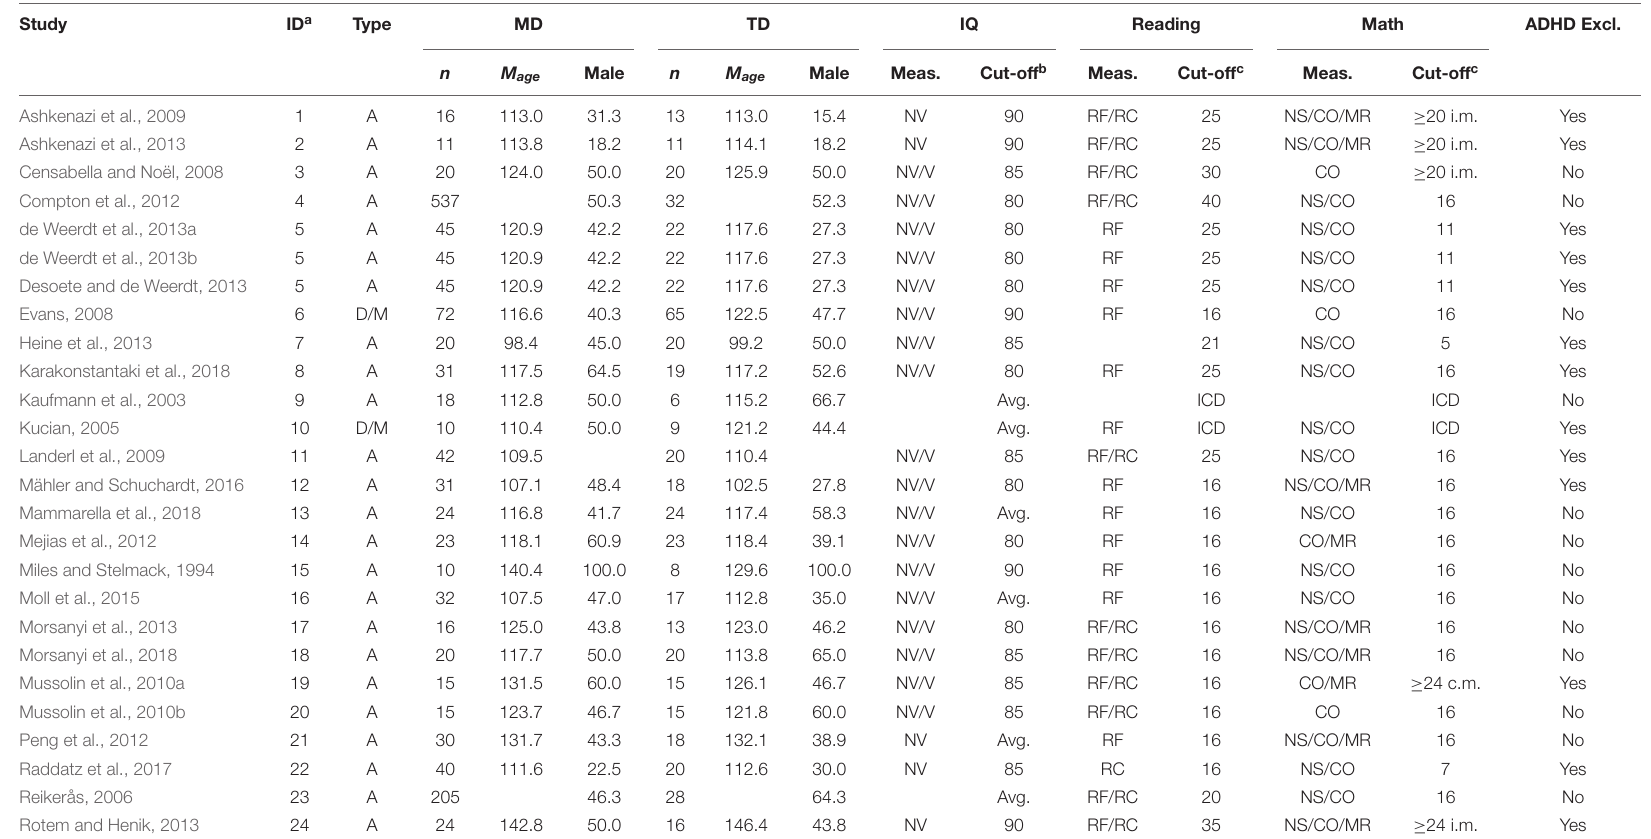
TABLE 1 | Descriptive characteristics of included studies and data